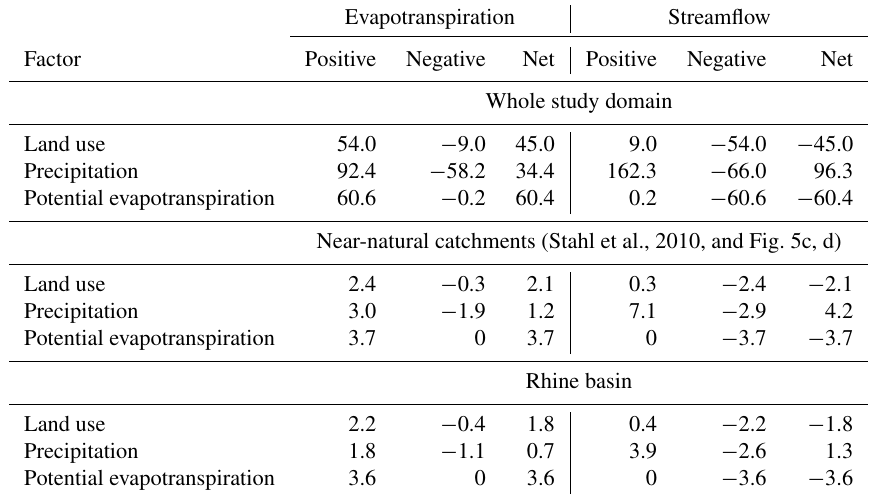
Table 2. Climate and land use contributions to changes in evapotranspiration and streamflow over the period 1960–2010. All units in km 3 yr − 1 . For reference, 1km 3 yr − 1 corresponds to an average discharge of 32m 3 s − 1 . The total area with available data is 4312807km 2